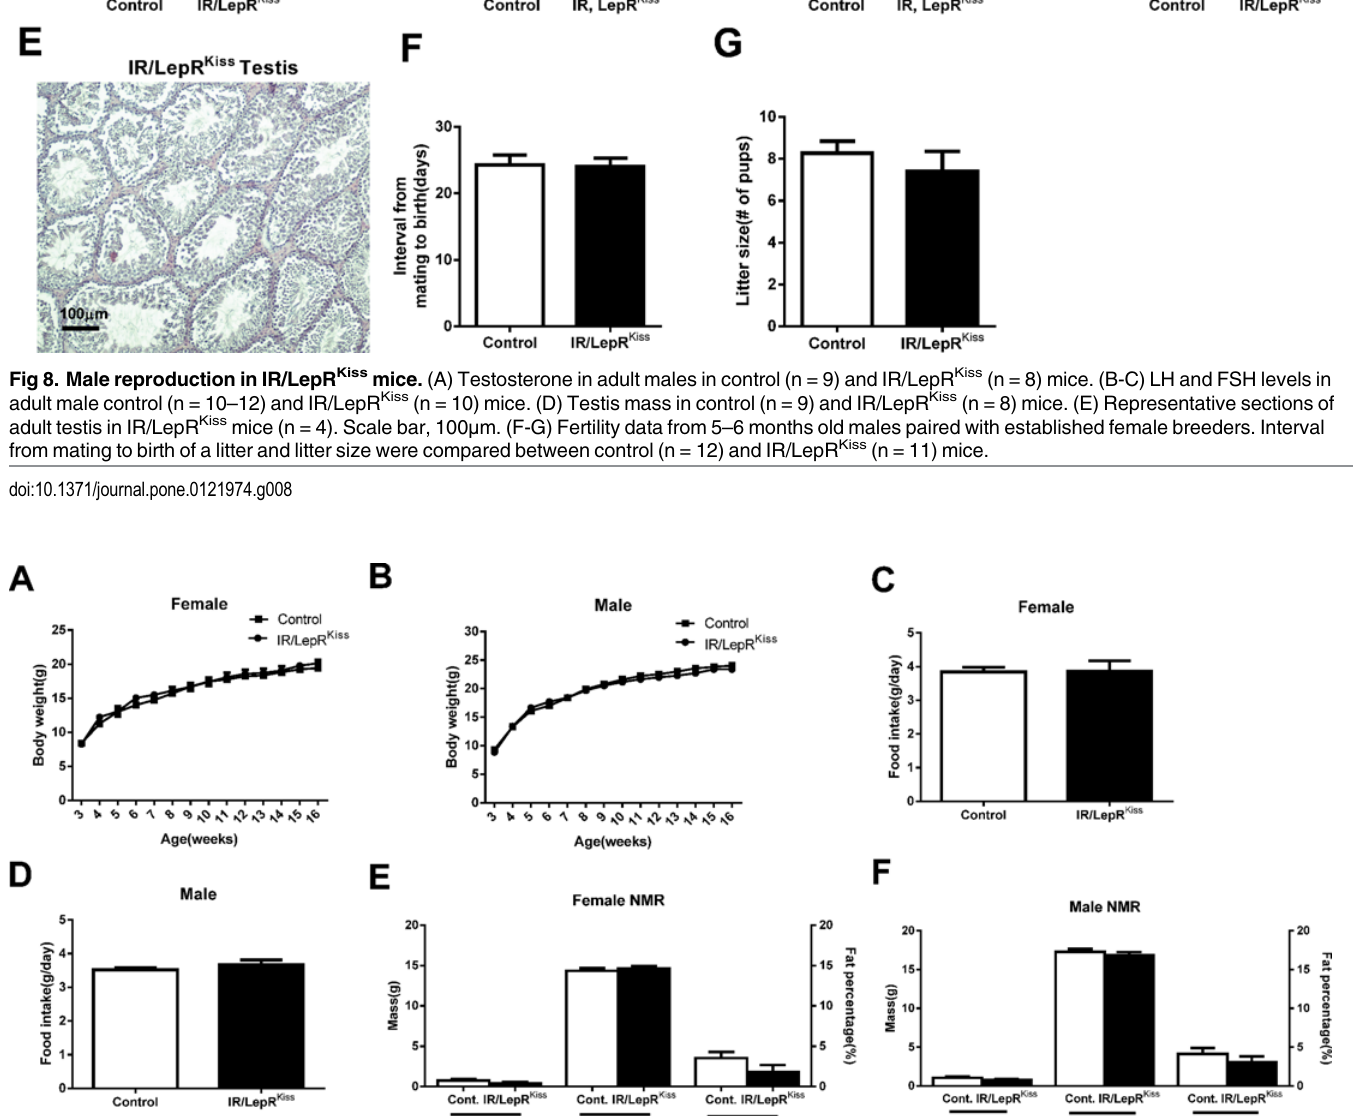
PLOS ONE | DOI:10.1371/journal.pone.0121974 May 6,